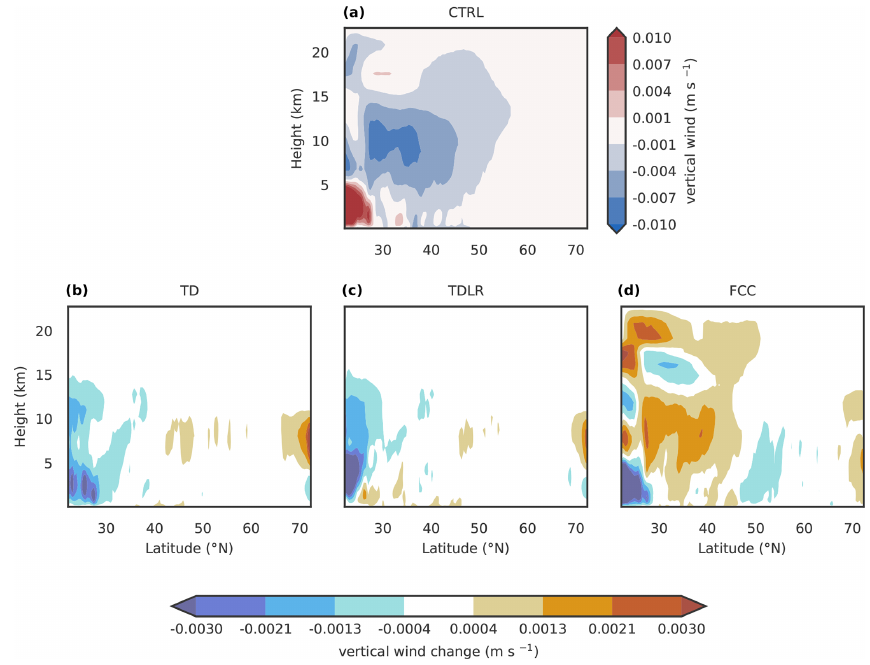
Figure 5. Meridional cross section of mean summer vertical wind (positive values mean upward motion) in the historical CTRL simulation and changes in the idealized simulations. (a) Vertical wind in CTRL for the average summer in the 1971–2000 period. (b) Change in vertical wind in the idealized TD simulation, representing RCP8.5 and the 2070–2099 period. (c) Same as panel (b) but for TDLR. (d) Same as panel (b) but for the FCC, which is the GCM-driven transient regional climate simulation. This figure shows only data from the simulations based on the GCM HadGEM2-ES since the necessary three-dimensional model output was only stored for these